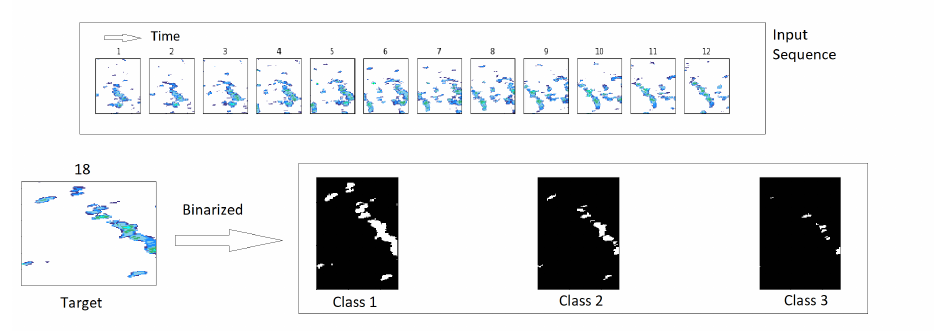
Figure 6. An example of the rain channels of an input sequence starting on the 7 January 2016 at 07:00:00. On the top is represented the input sequence: 12 time steps corresponding to the rain radar images collected five minutes apart over an hour. On the bottom are represented on the left side the rain radar image collected 30 min after the last one of the input sequence, and on the right side the target (the same image thresholded to the 3